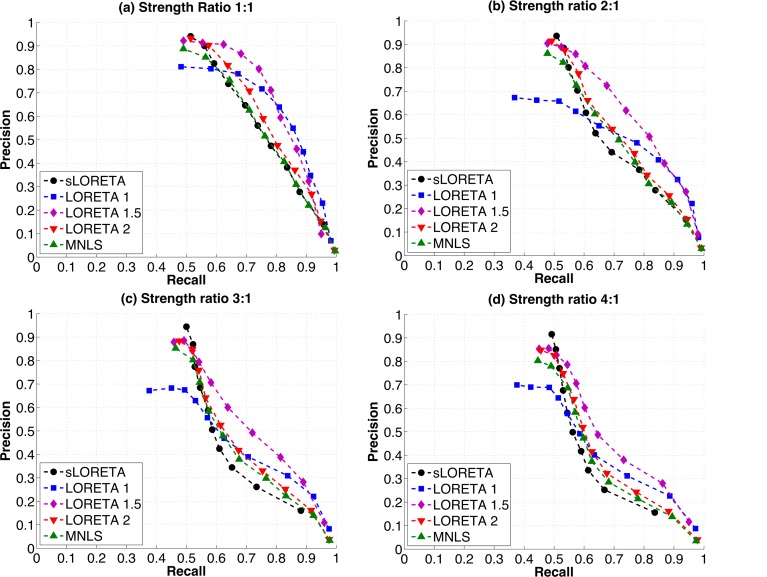
Precision vs. Recall curves for two sources with varying strength ratios: (a) two sources with the same strength (b) two sources, one with twice the strength as the other (c) two sources, one with three times the strength as the other (d) two sources, one with four times the strength as the other.Note that while sLORETA has highest peak Precision for all strength ratios, Precision also drops off more steeply with increasing Recall for this algorithm. This pattern is emphasized as the strength ratio increases. All other algorithms have similar performance to each other, with slightly decreasing Precision and Recall as the strength ratio of the sources increases.